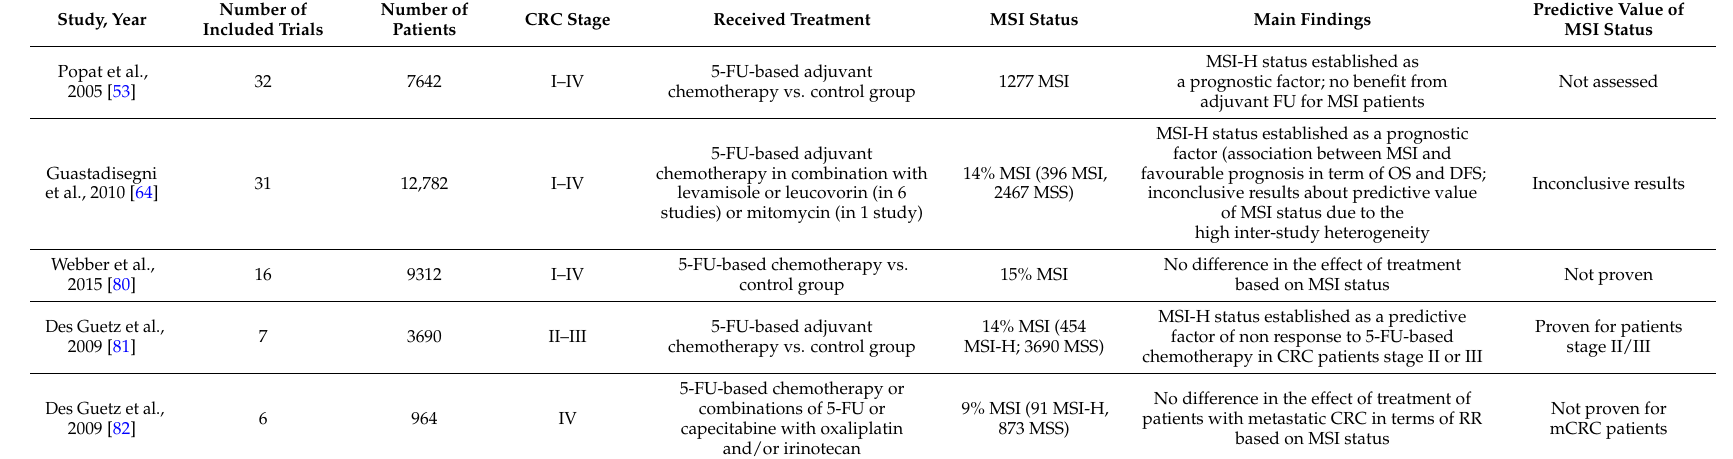
Table 1. Characteristic of available meta-analysis on prognostic and predictive value of microsatellite instability